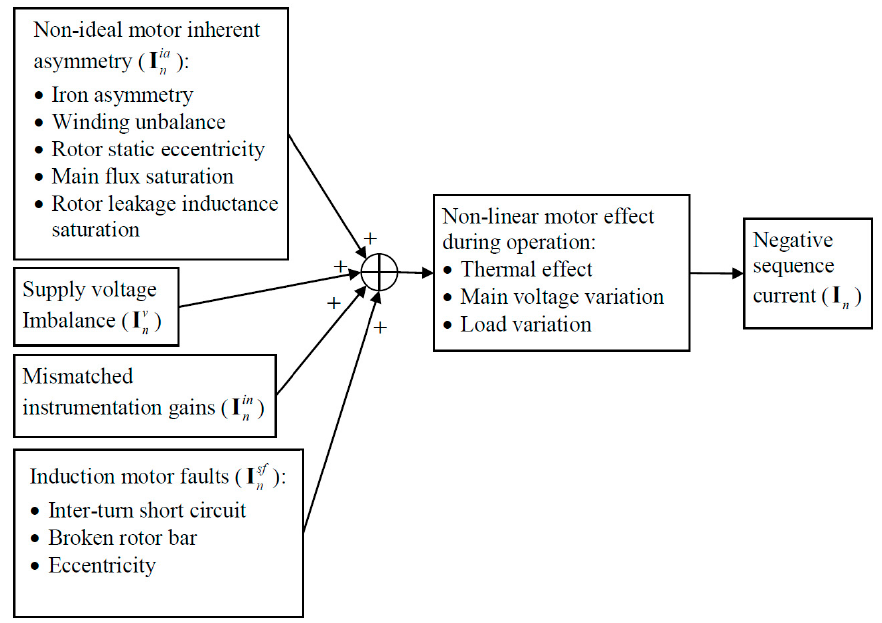
Figure 3. Main sources of negative sequence currents in induction motors.